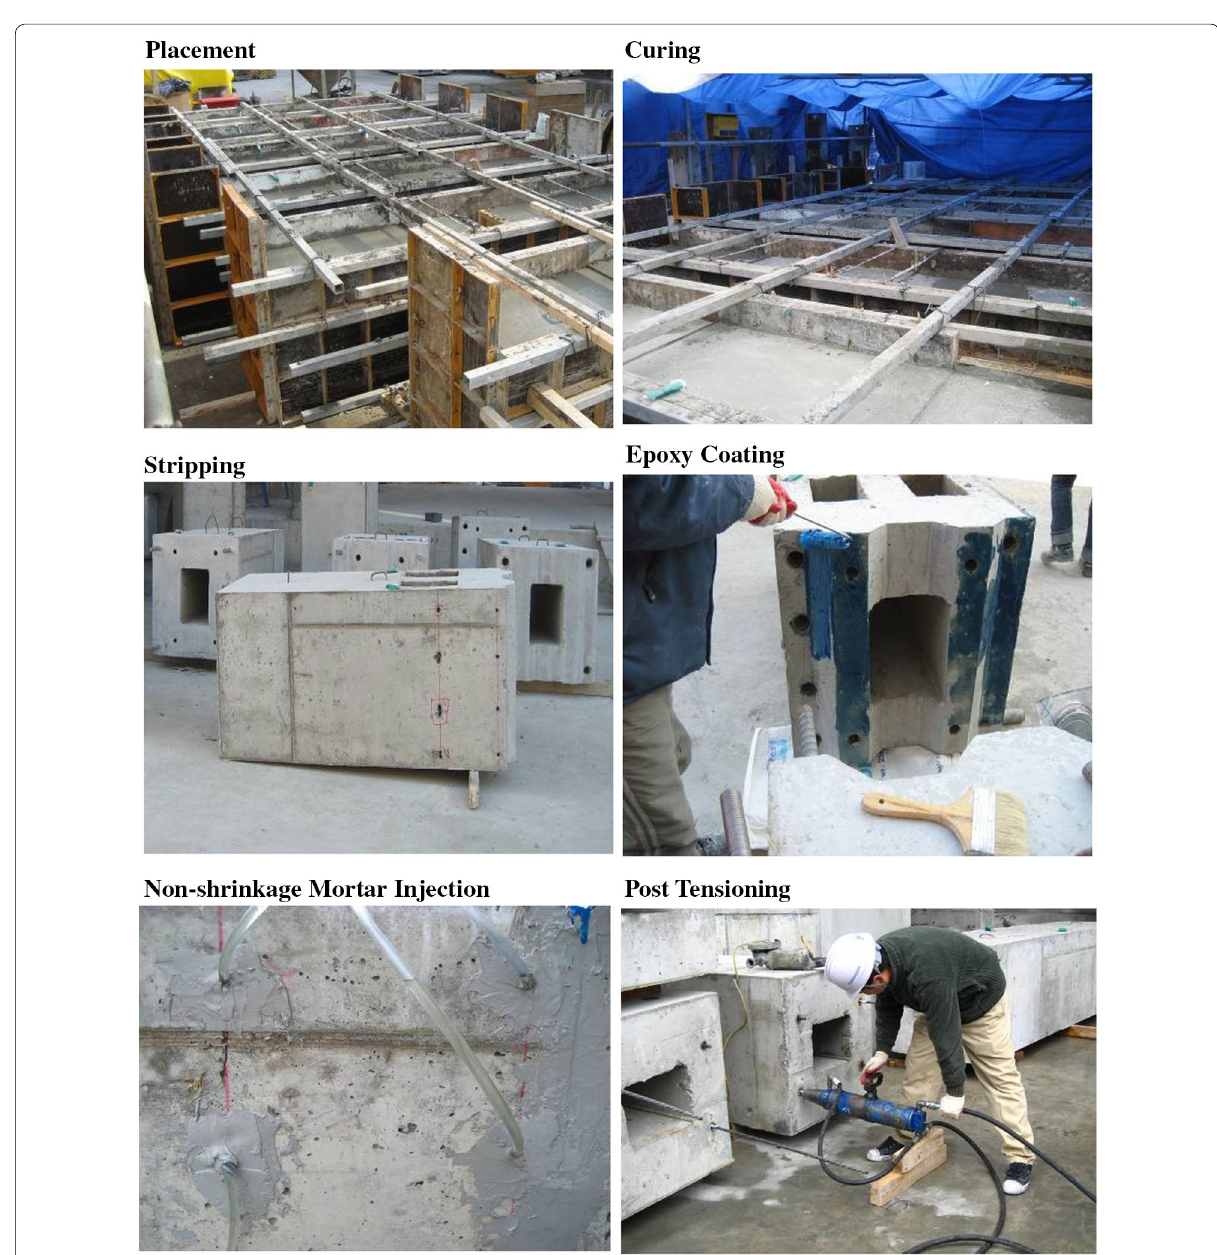
Fig. 5 Specimen manufacturing